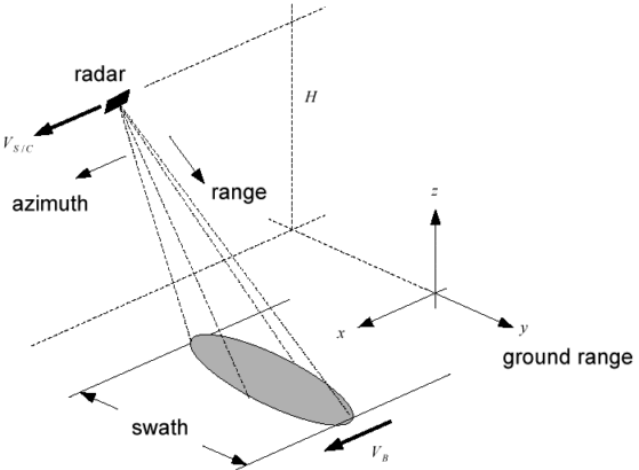
Figure 1. SAR Data acquisition